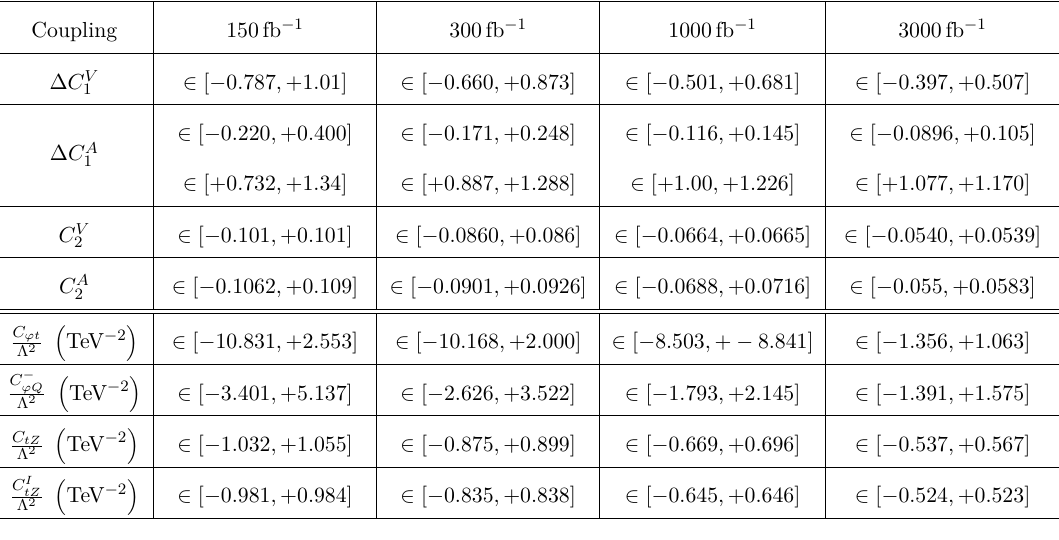
Table 1 . One parameter 95% C.L. limits on the couplings in the t ¯ tZ : 4 l channel at